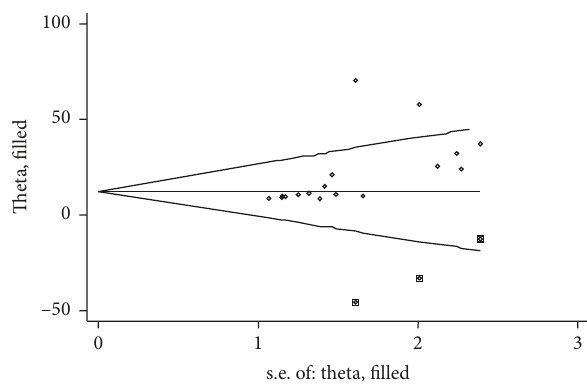
1 2 30 s.e. of: theta, Figure 4: Funnel plots presenting the resulting trim and fill analysis for correcting publication bias. The circular dots indicate the included studies, and the rectangular dots display the missing studies imputed by the trim and fill method.